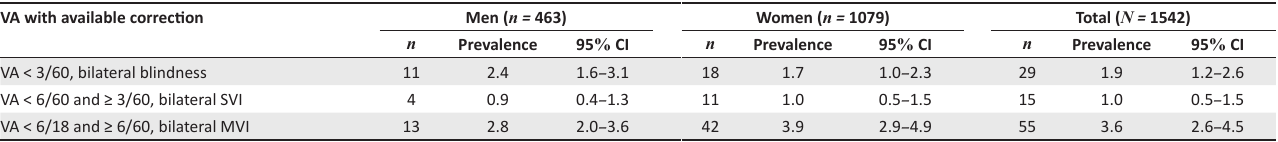
TABLE 2: Distribution by presenting visual acuity (with available correction) in the better eye (before pinhole examination). VA with available